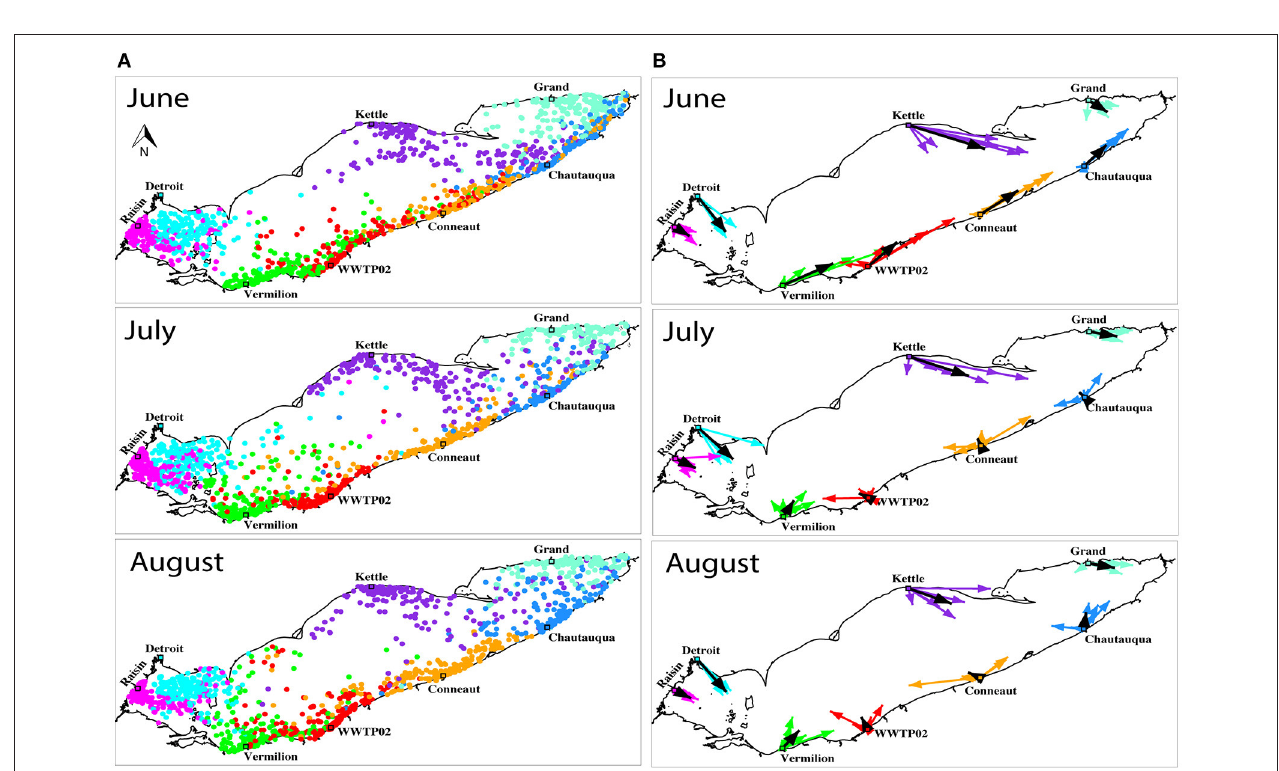
FIGURE 9 | (A) The distribution of neutrally buoyant particles at the end of month-long transport in June, July, and August for 6 years. For visual simplicity, 8 of the 29 sources (influents) are depicted: the Raisin Rv. (magenta), Detroit Rv. (cyan), Kettle Rv. (purple), Grand Rv. (turquoise), Chautauqua Rv. (blue), Conneaut Rv. (orange), Cleveland WWTP (red), and Vermillion Rv. (green). (B) Mean transport vectors summarizing the positions of all particles at the end of month at each of the same eight representative sources (similarly colored coded). The six vectors per source represent mean transport for each of the 6 years. The 6-year mean vector is shown in black at each